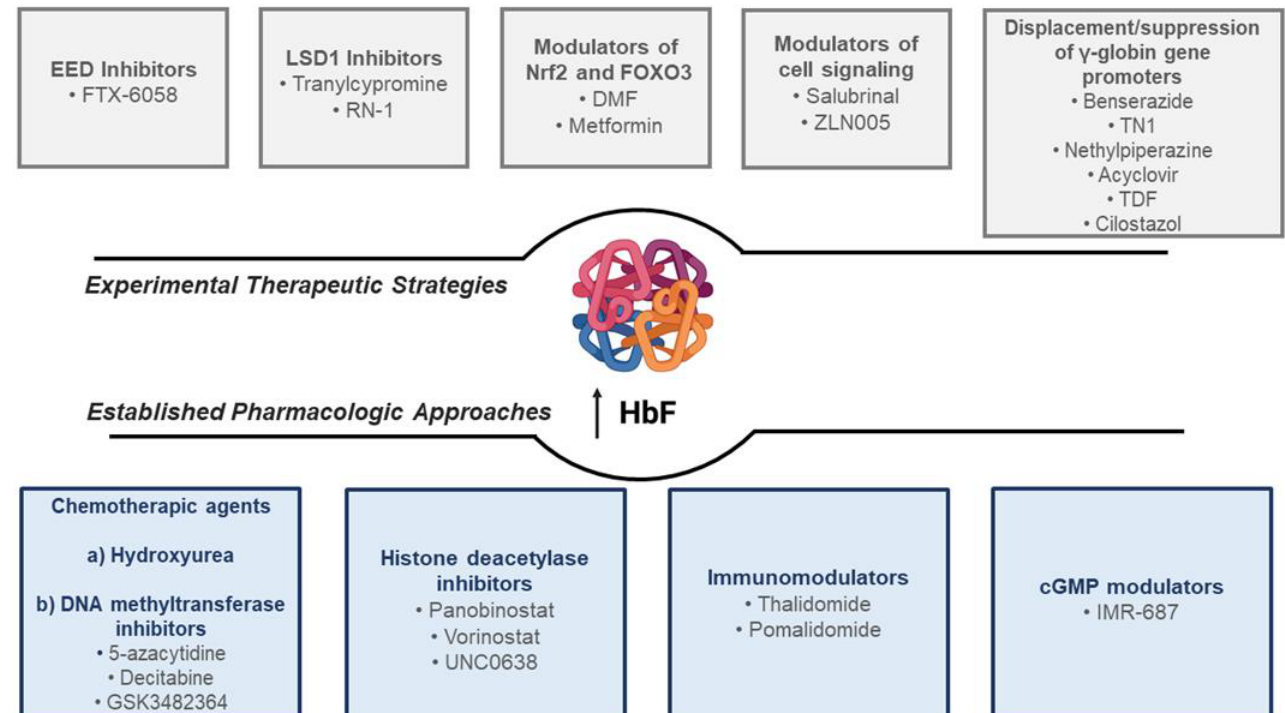
Figure 1. Summary of all established pharmacological approaches and experimental therapeutic strategies for HbF induction in β -thalassemia and SCD.